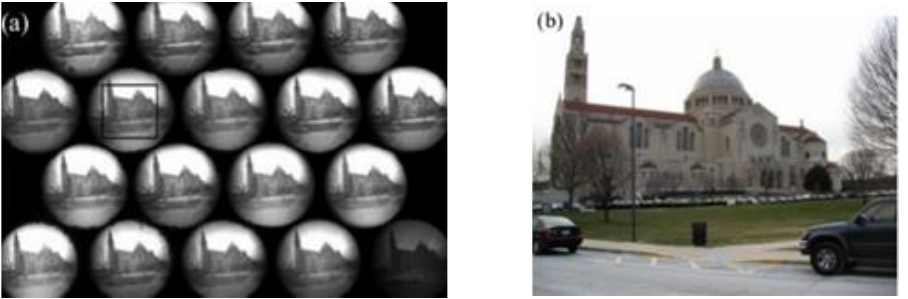
Figure 26. Target images taken using different cameras. ( a ) A complete image of a target obtained using a multispectral camera. ( b ) An image of the object taken using a conventional camera.